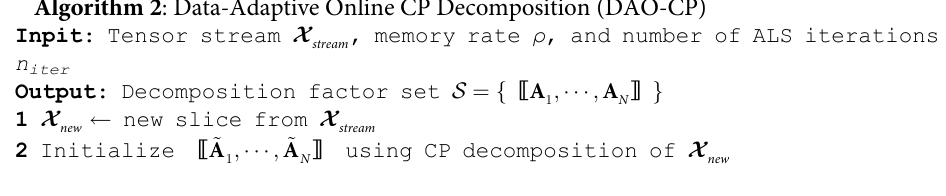
is the threshold of splitting and initializing the s